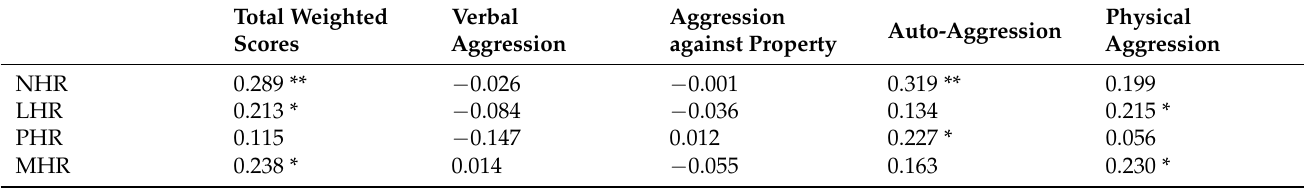
Table 3. Correlations among the NHR, LHR, MHR, PHR and the MOAS in the aggressive group.